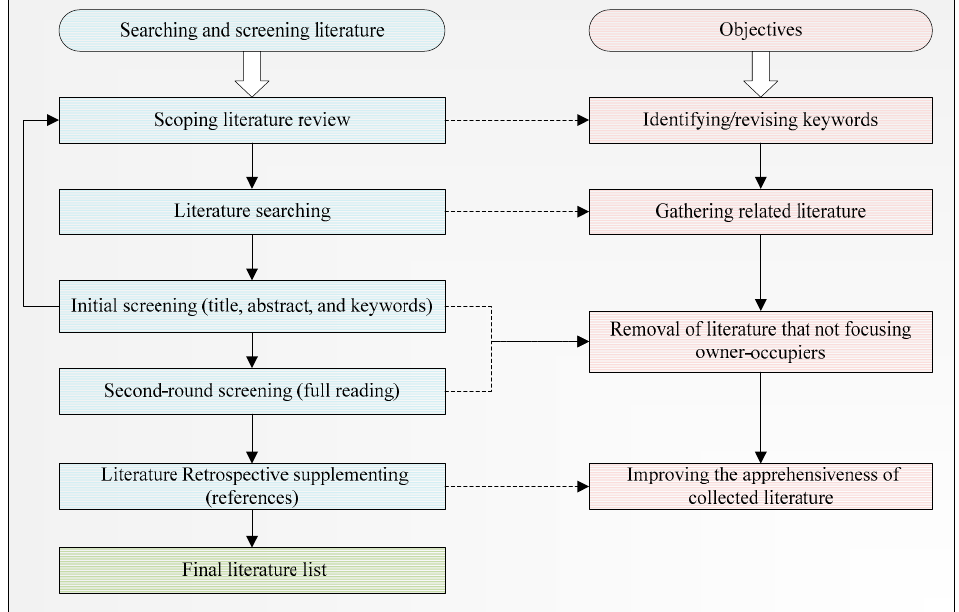
Figure 1. The process of data